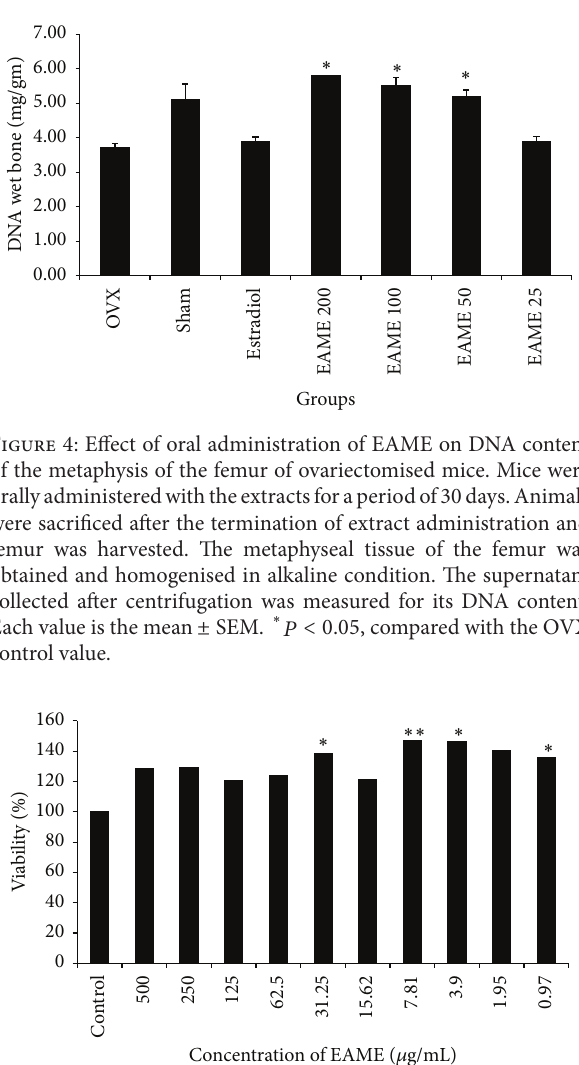
Figure 5: Effect of EAME on the viability of mice splenocytes. Viable cells as determined by MTT assay. Mice splenocytes (1.5 × 10 5 cells/well) were plated and cultured 72 hr. in the absence or presence of different concentration of extracts. Each bar represents mean ± SEM. ∗ 𝑃 < 0.05 , compared with the control value.